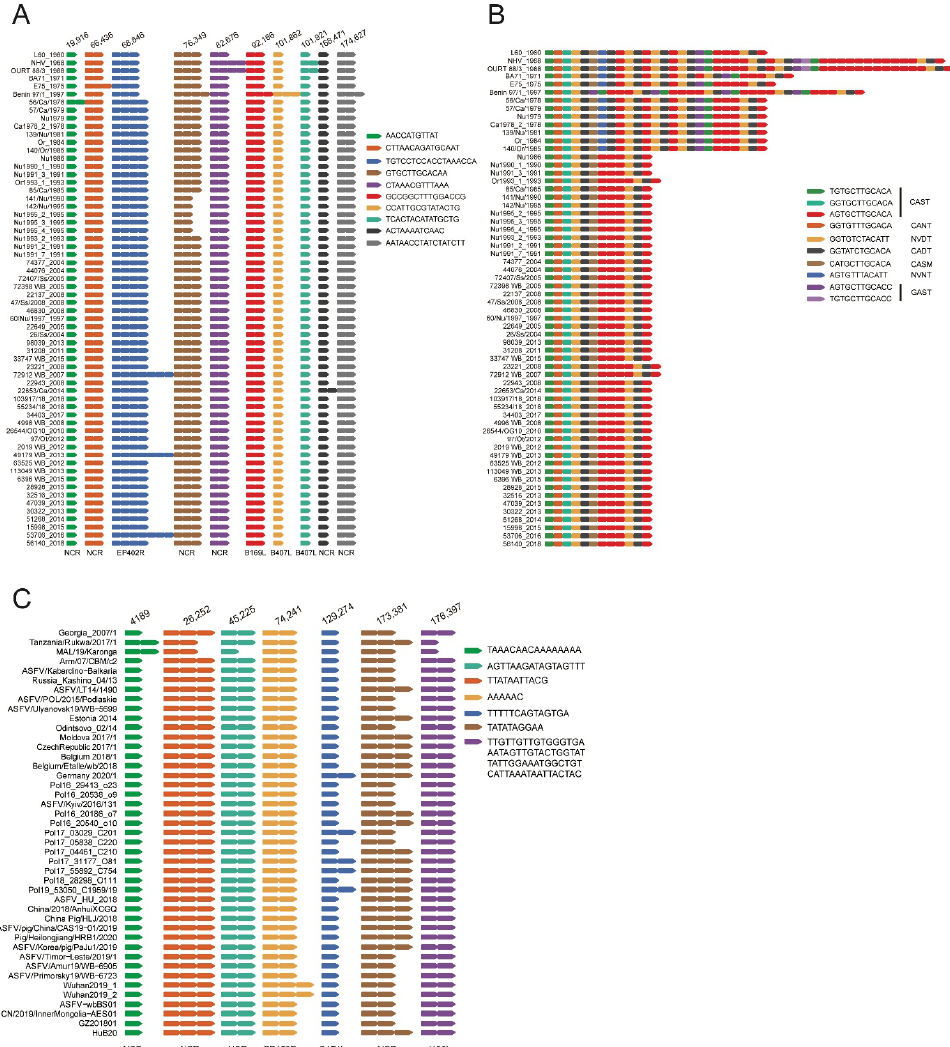
Figure 5. Sequence variation of the tandem repeat sequences (TRS) in ASFV genomes. ( A ) Variation of TRS in other regions in ASFV genotype I genomes. ( B ) Variation of TRS in the coding region of B602L gene in ASFV genotype I genomes. ( C ) Variation of TRS in ASFV genotype II genomes. The arrangement of the TRS in each genome was listed according to the nucleotide sequence. Each arrow of a different color represents a type of repeat unit with a specific nucleotide sequence. The nucleotide sequence of each type of repeat unit was also shown. The amino acid sequence of each type of repeat unit in the TRS in the coding region of B602L gene was also shown.